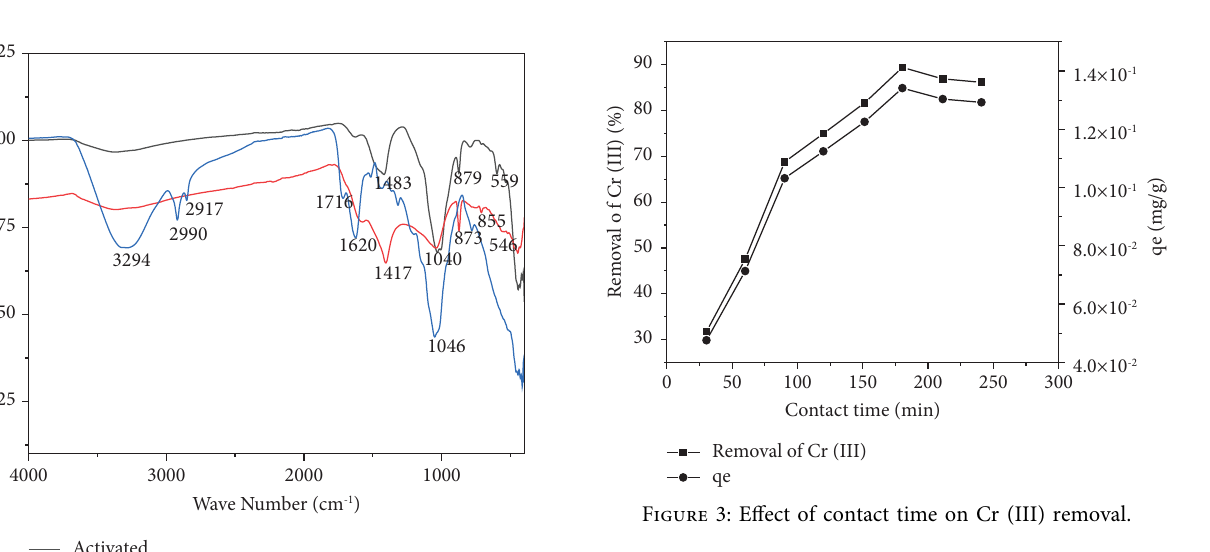
Figure 1: SEM image of Cordia africana before activation (a) and after activation (b).